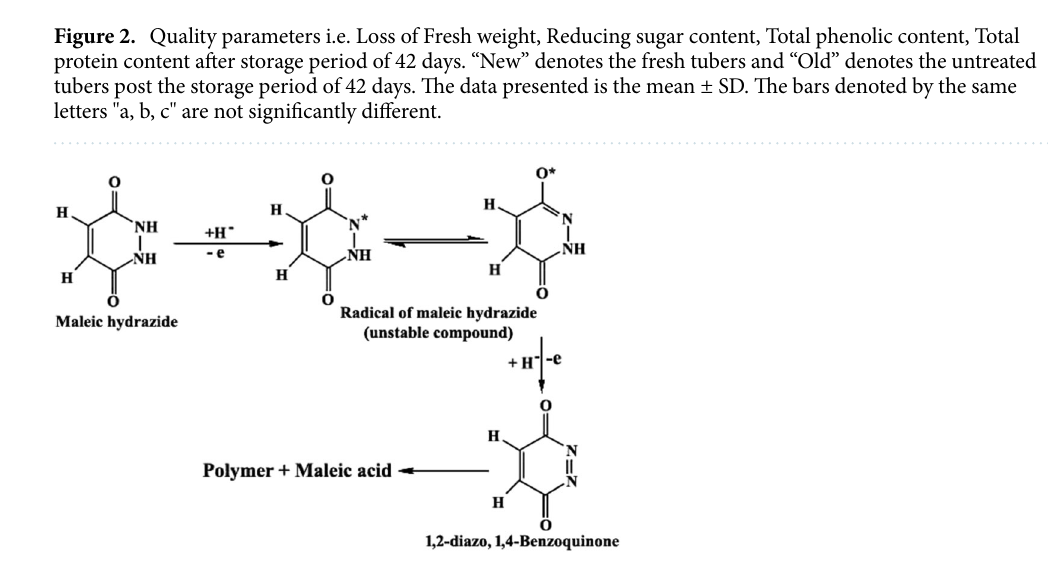
Figure 3. The tentative mechanism of activity of the antisprouting